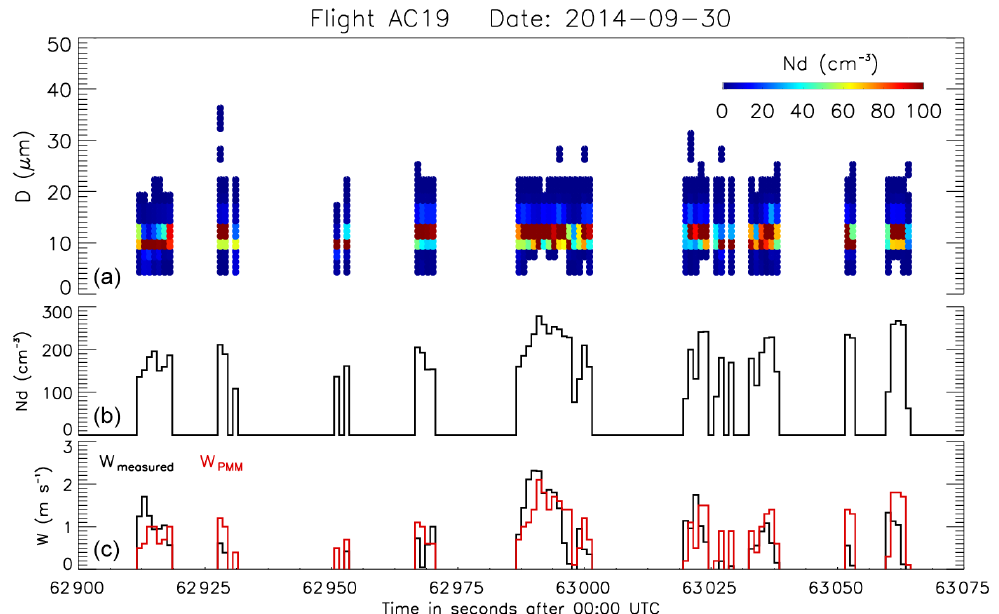
Figure 2. Time series of (a) droplet size distribution measured by CCP-CDP, (b) number concentration of droplets ( N d ), (c) measured vertical velocities w , and estimated w based on the PMM. The measurements were performed during flight AC19 above the Atlantic Ocean.